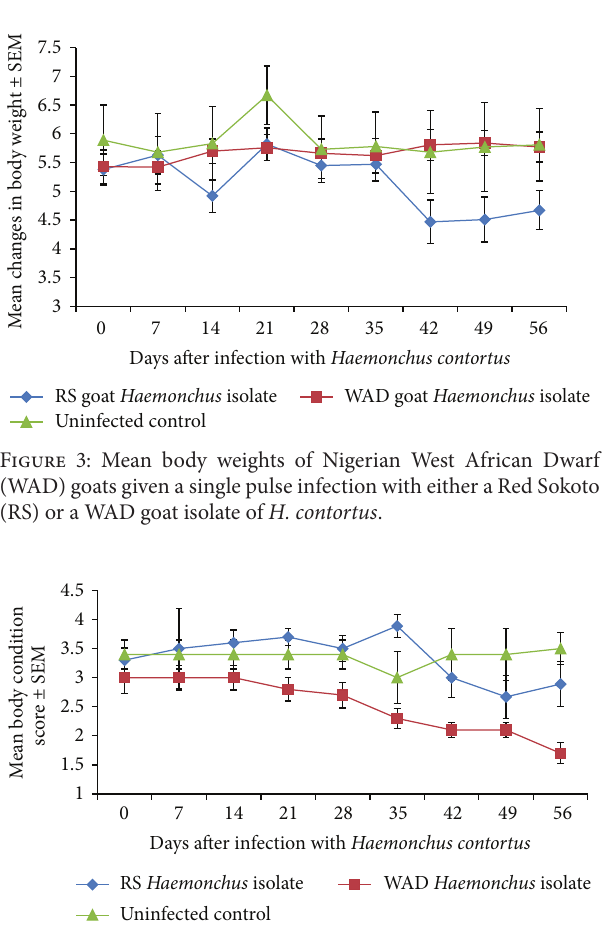
Figure 4: Mean body condition score of Nigerian West African Dwarf (WAD) goats given a single pulse infection with either a Red Sokoto (RS) or a WAD goat isolate of H. contortus